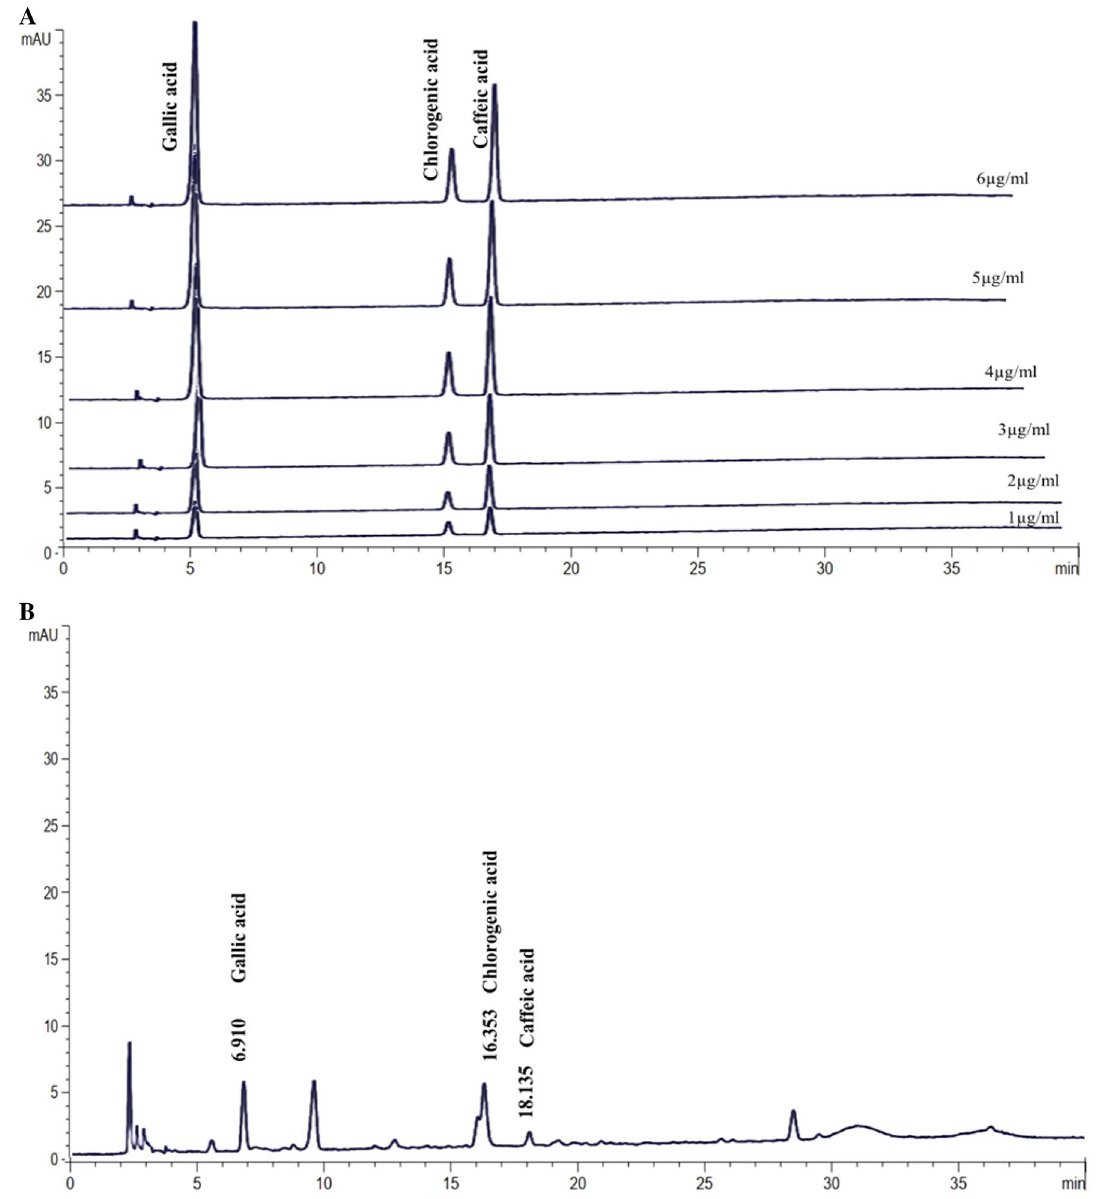
Figure 1. HPLC analysis of roselle extract. ( A ) HPLC chromatograms of standard gallic acid, chlorogenic acid and caffeic acid solutions at concentration 1, 2, 3, 4, 5, 6 µg/mL. ( B ) HPLC chromatogram of roselle extract at a wavelength of 280